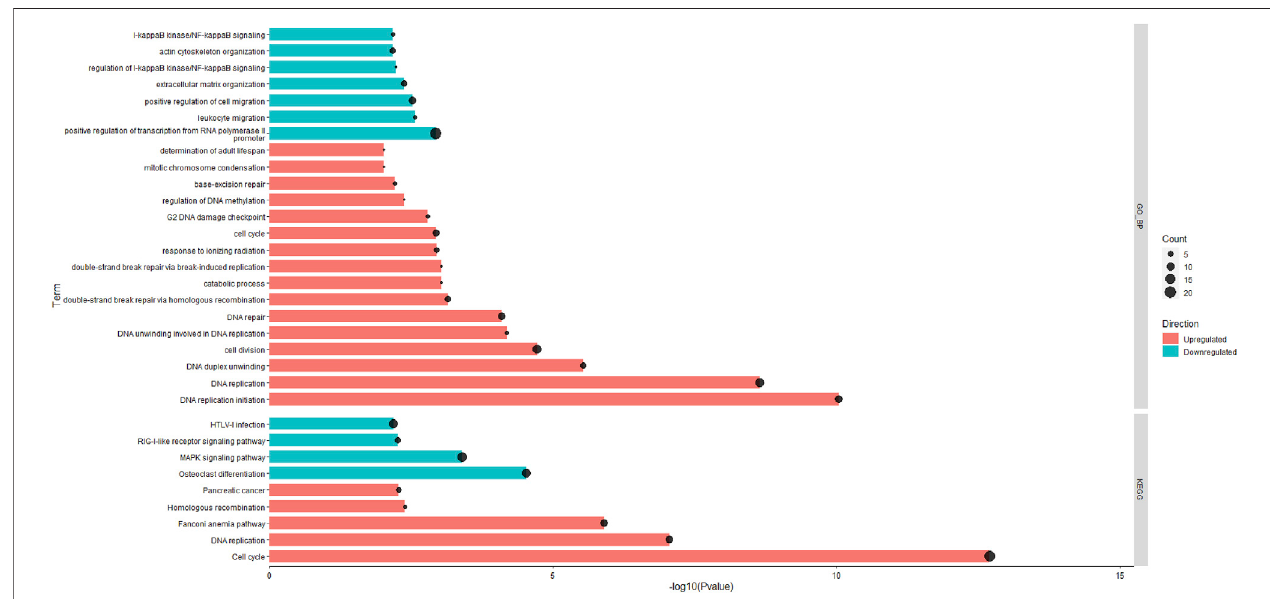
FIGURE 2 | The signi fi cantly enriched pathways in rumen epithelial tissues of the HS and the PFTN cows as determined using Database for Annotation, Visualization and Integrated Discovery (DAVID) analysis against the GO_BP and KEGG